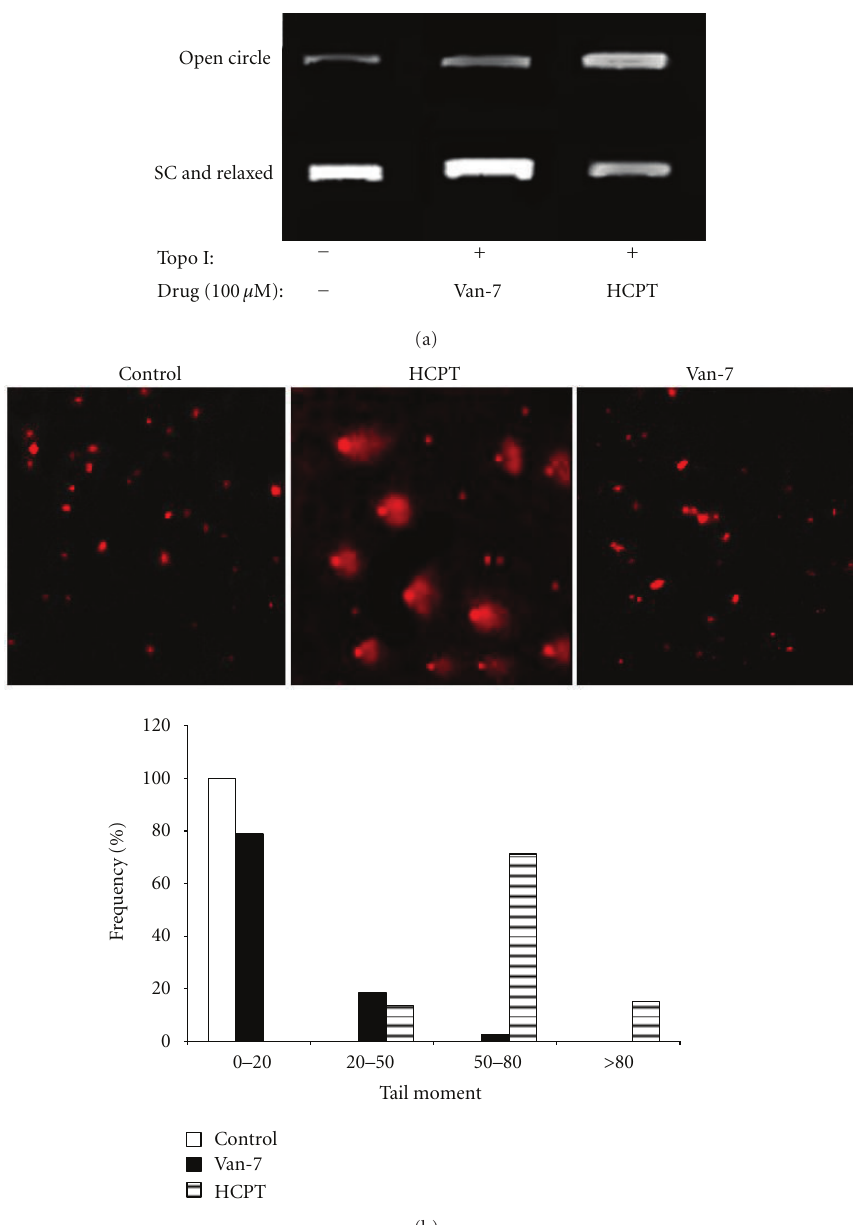
Figure 3: (a) Representative image of agarose gel electrophoresis of the cleavage assay. Only HCPT induced the formation of a slow migrating complex formed by enzyme, drug, and DNA, whereas Van-7 did not. (b) Comet assay performed in isolated nuclei in the presence of the vehicle, HCPT (40 μ M), or Van-7 (40 μ M). Tail moment for each comet was calculated. Nuclei were grouped according to the tail moment value in three groups, and the frequency distribution is shown in the bar chart. DNA damage is increased in nuclei with the highest tail moment